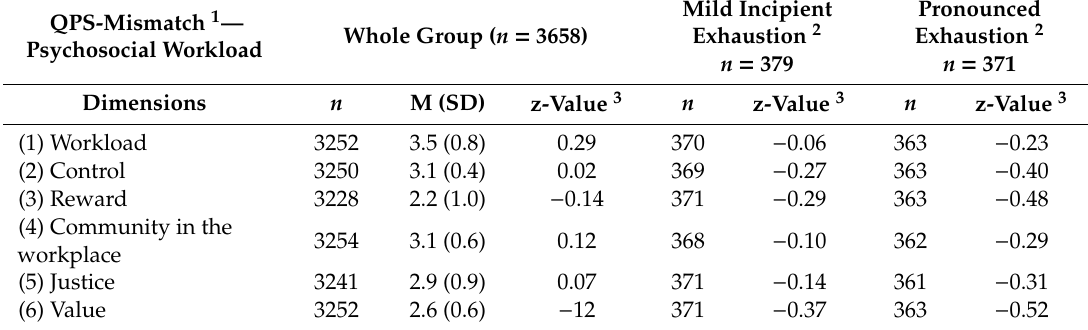
Table 4. Deviations in psychosocial workload among Swedish occupational therapists in relation to the QPS Nordic 1 reference group’s average score in the group as a whole and on sub-group levels among those who reported having symptoms of mild or pronounced exhaustion ( n =